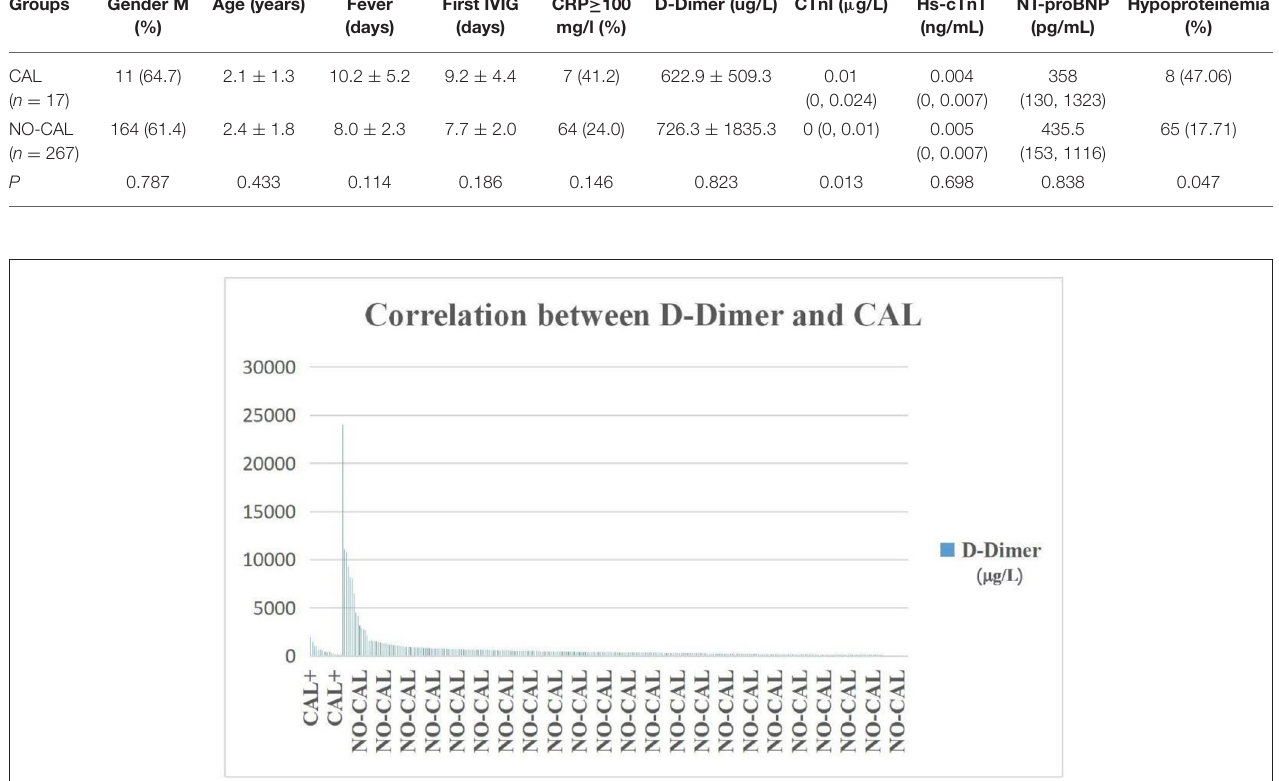
TABLE 4 | The correlation between CAL and CRP/D-Dimer/myocardial damage/Hypoproteinemia.